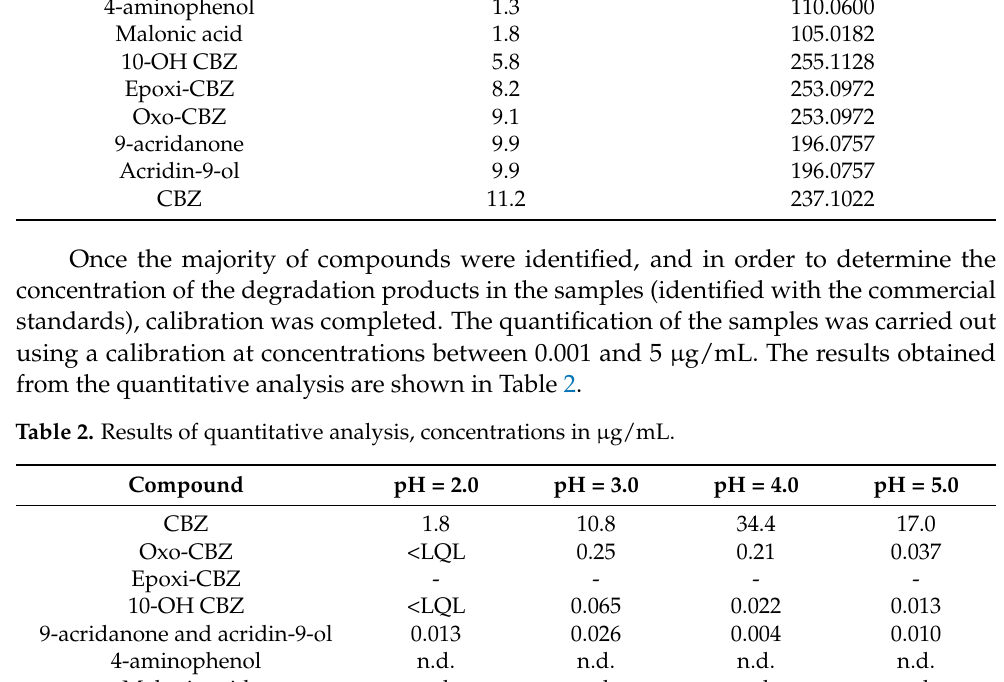
Table 2. Results of quantitative analysis, concentrations in μ g/mL.